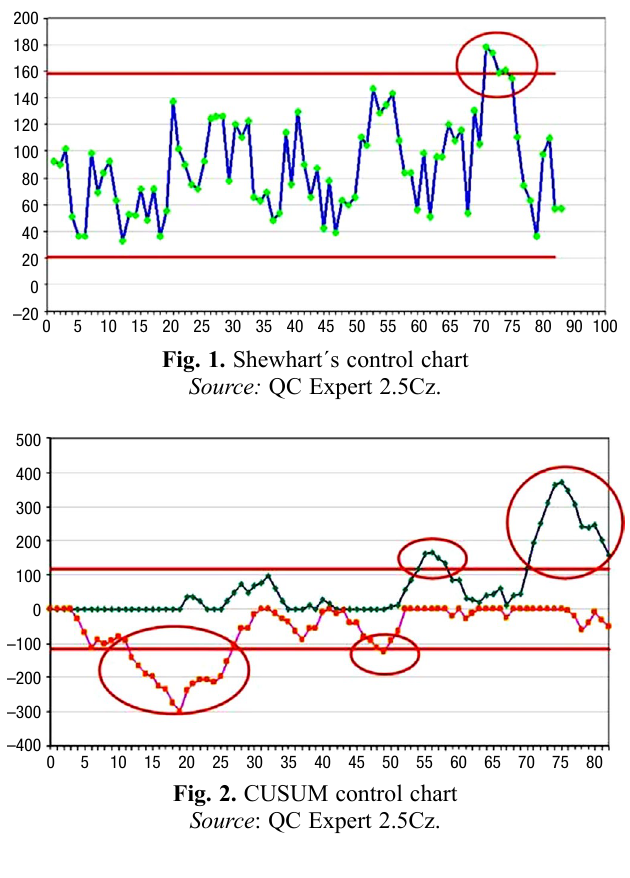
Fig. 2. CUSUM control chart Source : QC Expert